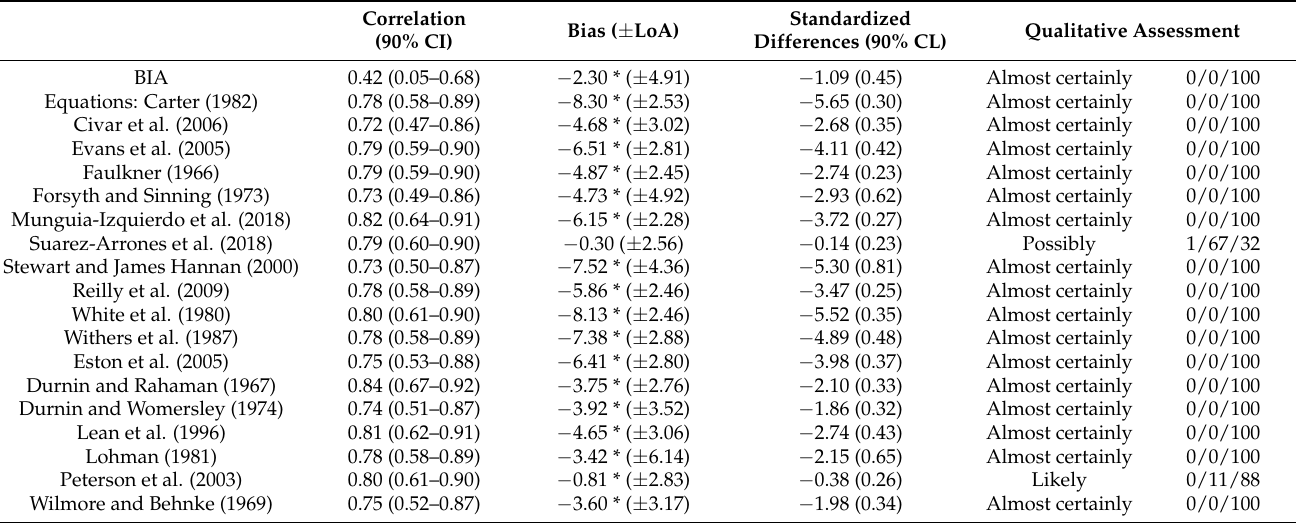
Table 2. Cross-sectional validity of body fat percentage measurements made by BIA and anthropo- metric equations using DXA as reference in elite male soccer players ( n =